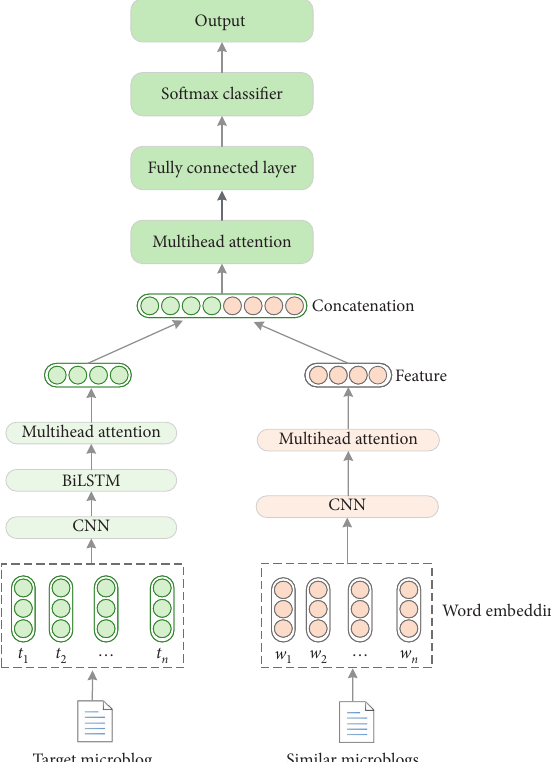
Figure 3: The sentiment analysis process of CNN-BiLSTM-At- tention network.